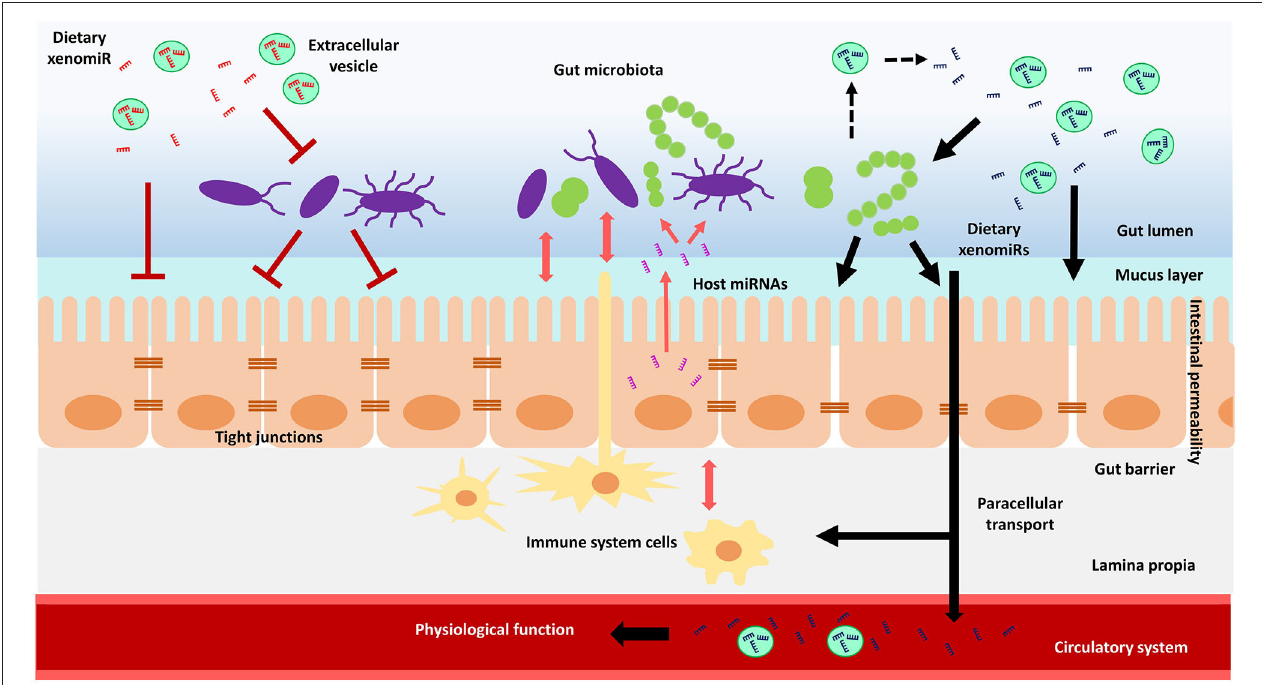
FIGURE 1 | Schematic model of the hypothetical interactions of dietary plant xenomiRs with mammalian cells in the gastrointestinal tract. Gut microbiota could have an impact on intestinal barrier integrity and function, which in turn could modulate gut microbiota through molecules such as miRNAs. There could be also a crosstalk of immune system with both, intestinal barrier and gut microbiota. A certain xenomiR might promote or hinder its absorption depending on its effect on intestinal permeability, which might rely on the crosstalk between gut microbiota, intestinal epithelial cells and immune system. Gut microbiota might also be involved in the release of xenomiRs encapsulated in extracellular vesicles. The increase in intestinal permeability through, for example, altered tight junctions, might enhance xenomiR paracellular transport across the gut barrier, to eventually reach the circulatory system and potentially exert a physiological function in mammal tissues and